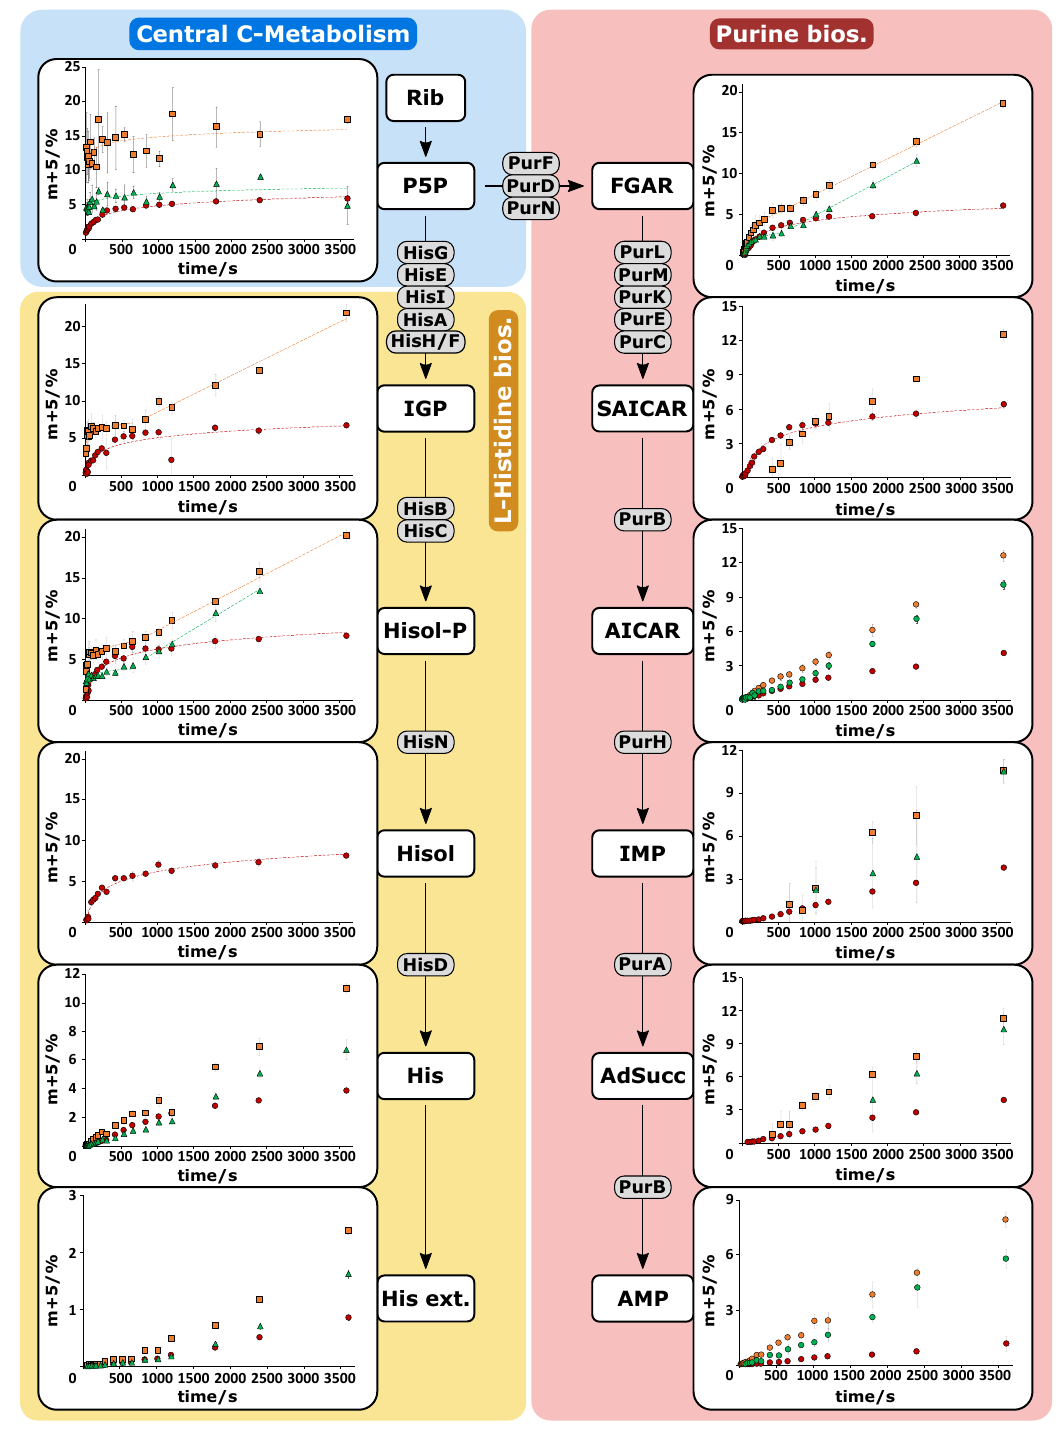
Figure 5. Propagation of 13 C 5 -ribose tracer signal in C. glutamicum HIS1 (red dots), HIS2 (orange squares), and HIS3 (green triangles). Error bars give the standard deviation of three